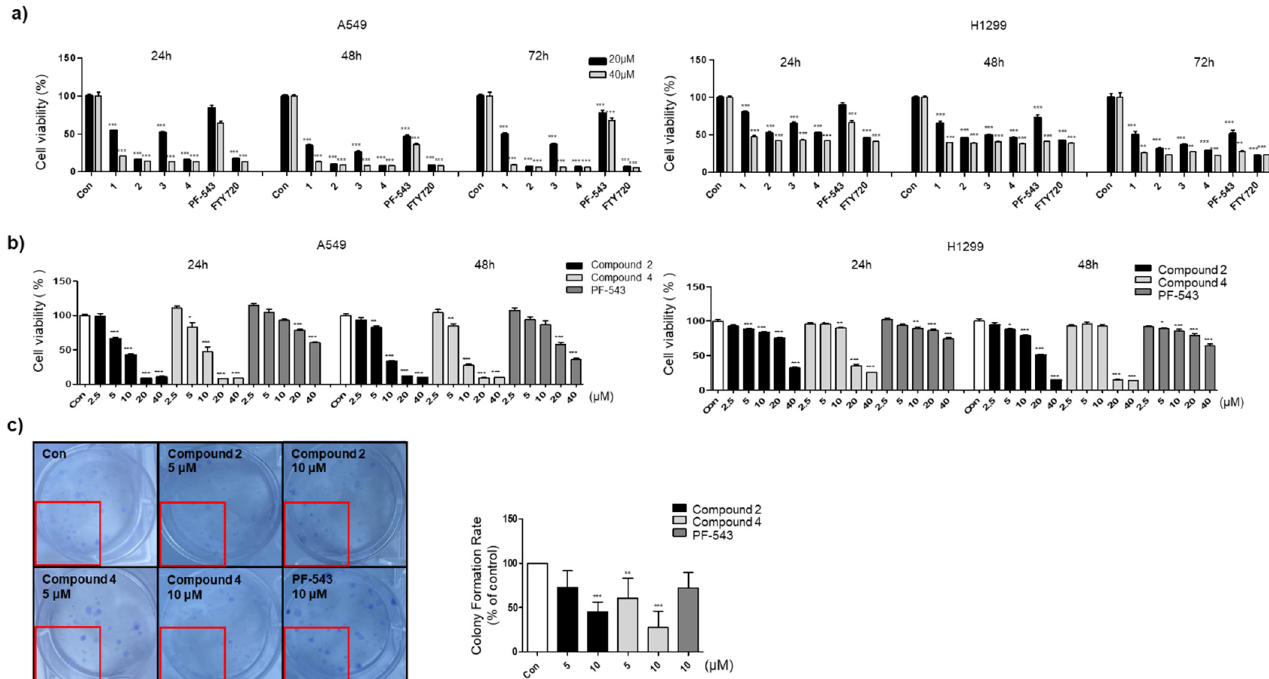
Figure 2. Cytotoxic effects of PF-543 and PF-543 derivatives in lung cancer cells; ( a ) Cell viability treated Compound 1 ‒ 4 , PF-543, and FTY720 for 24, 48, and 72 h in A549 and H1299 cells; ( b ) Compounds 2 and 4 and PF-543 were treated for 24 and 48 h by concentration (2.5, 5, 10, 20, 40 μ M) in A549 and H1299 cells; ( c ) Colony formation assay in A549 cells treated with PF-543 and PF-543 derivatives for 24 h. All experiments were repeated three times, and each value is expressed as the mean ± SD ( n = 3). * p < 0.05, ** p < 0.01, and *** p < 0.001 compared with control group.